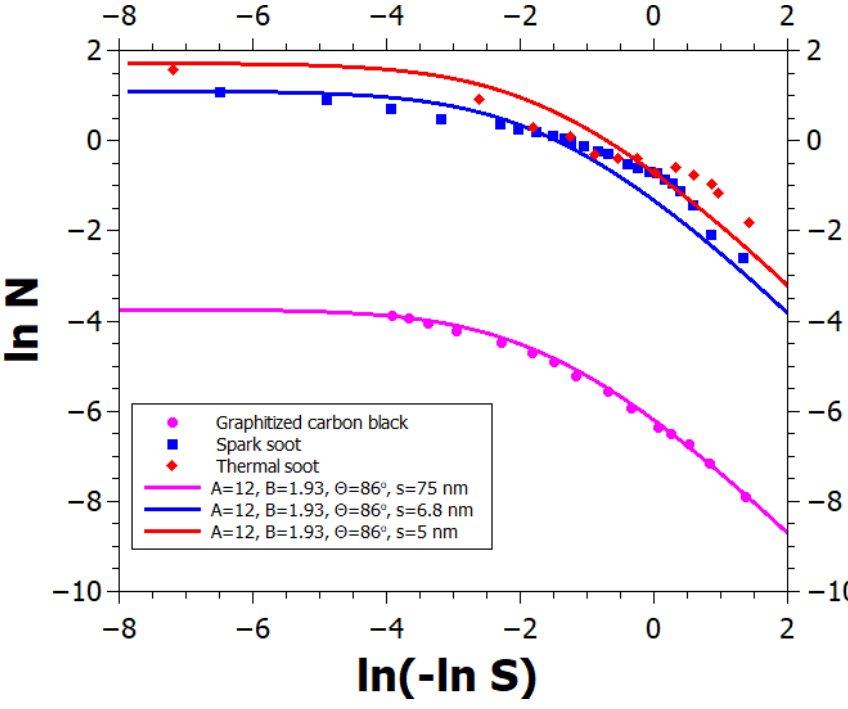
Figure 3. An FHH plot of experimental (markers) and modeled (lines) adsorption isotherms of water vapor on graphite and different soots. Note that increasing supersaturation is to the left on the abscissa. See text for